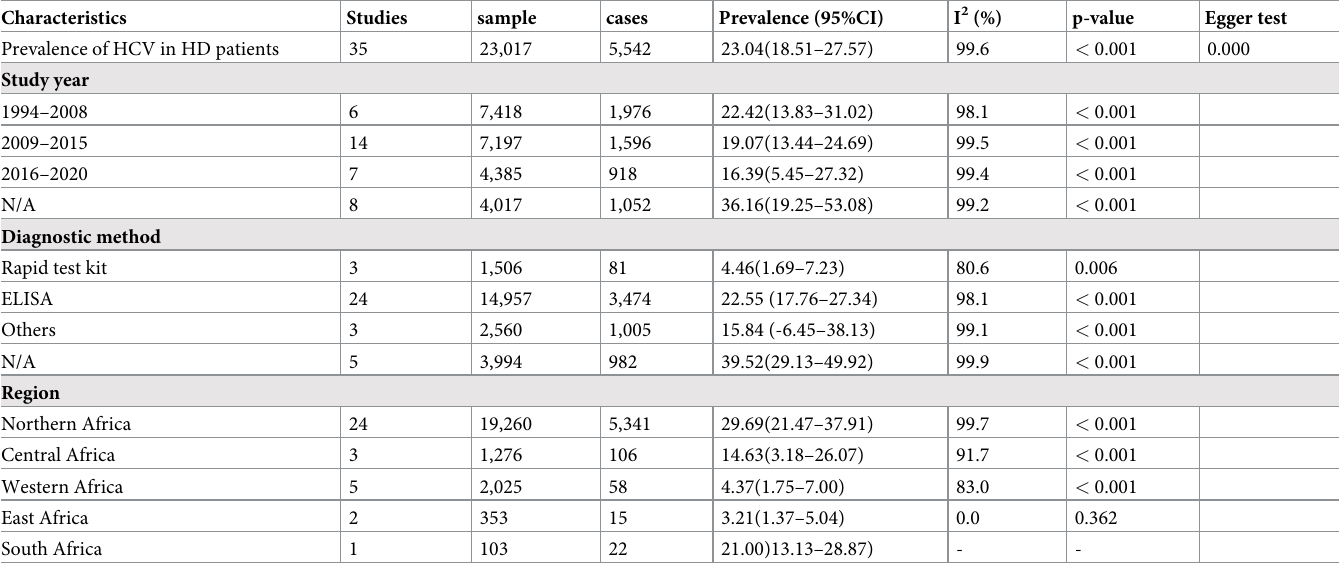
Table 3. Prevalence of HCV among HD patients in Africa.